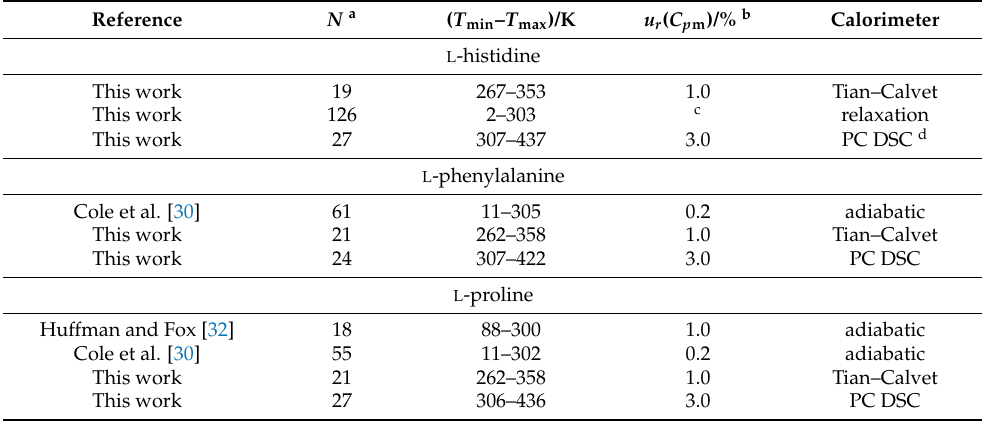
Table 3. Overview of the literature crystal heat capacities of L -histidine, L -phenylalanine, L -proline, L -tryptophan, and L